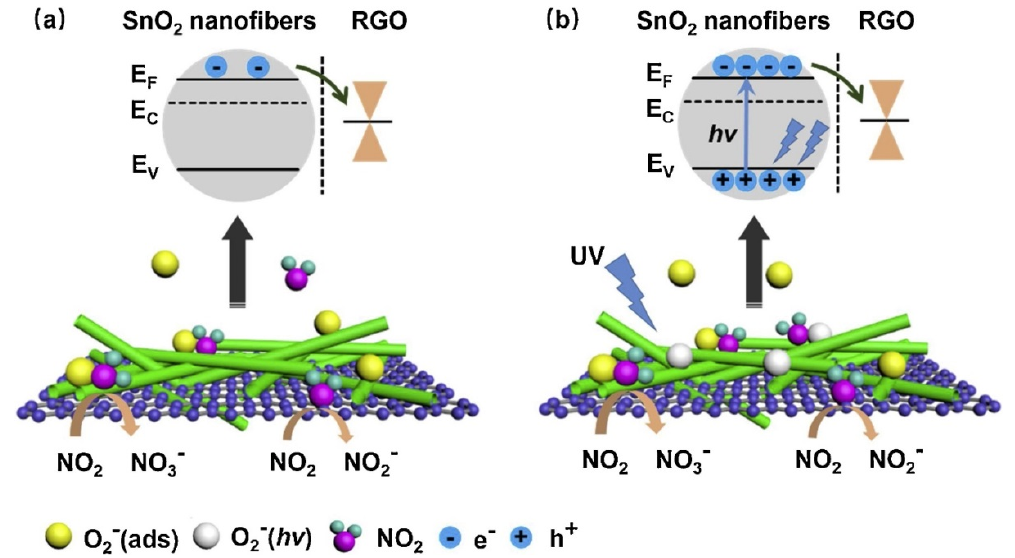
Figure 12. The sensing mechanism of rGO-loaded SnO 2 NFs to NO 2 ( a ) in the dark and ( b ) UV illumination [65]. Choi et al. [66] prepared 0.01 and 5 wt.% rGO-loaded SnO 2 NFs for sensing studies. In the 0.01 wt.% rGO-loaded sensor, the electrical transport and sensing characteristics of the sensor were dominated by the SnO 2 NFs, which showed an enhanced gas response to H 2 S. In contrast, in the sensor with 5 wt.% rGO, the rGO NSs showed an enhanced re-